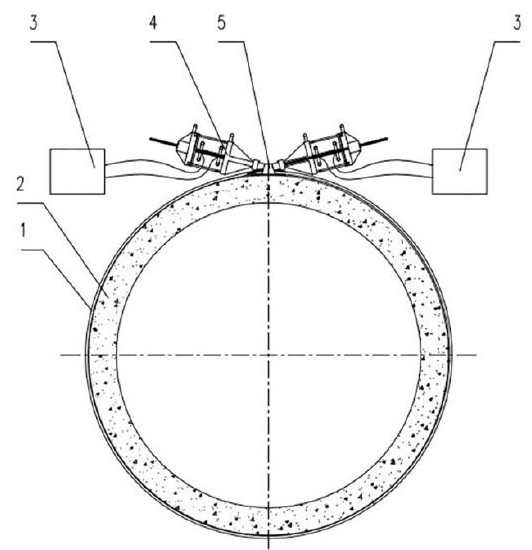
Figure 10. The schematic diagram of the tensioning system: 1—Strand; 2—PCCP; 3—Pump; 4—Jack; 5—Anchorage.